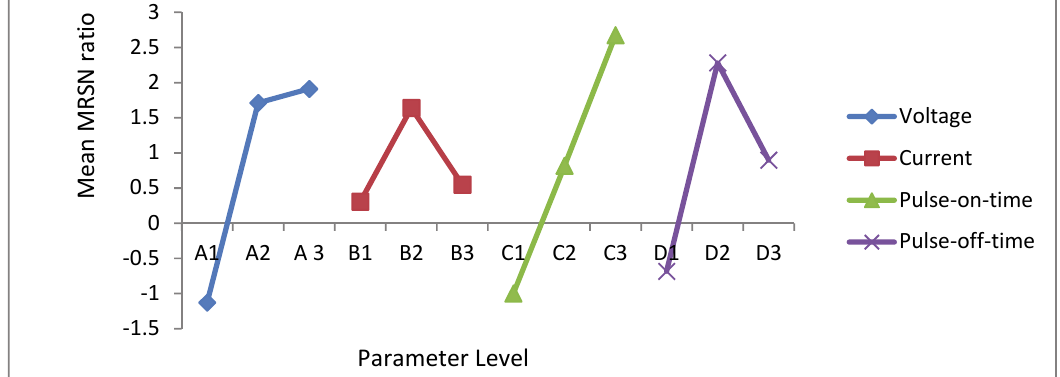
Fig. 3. Response graph of MRSN ratio